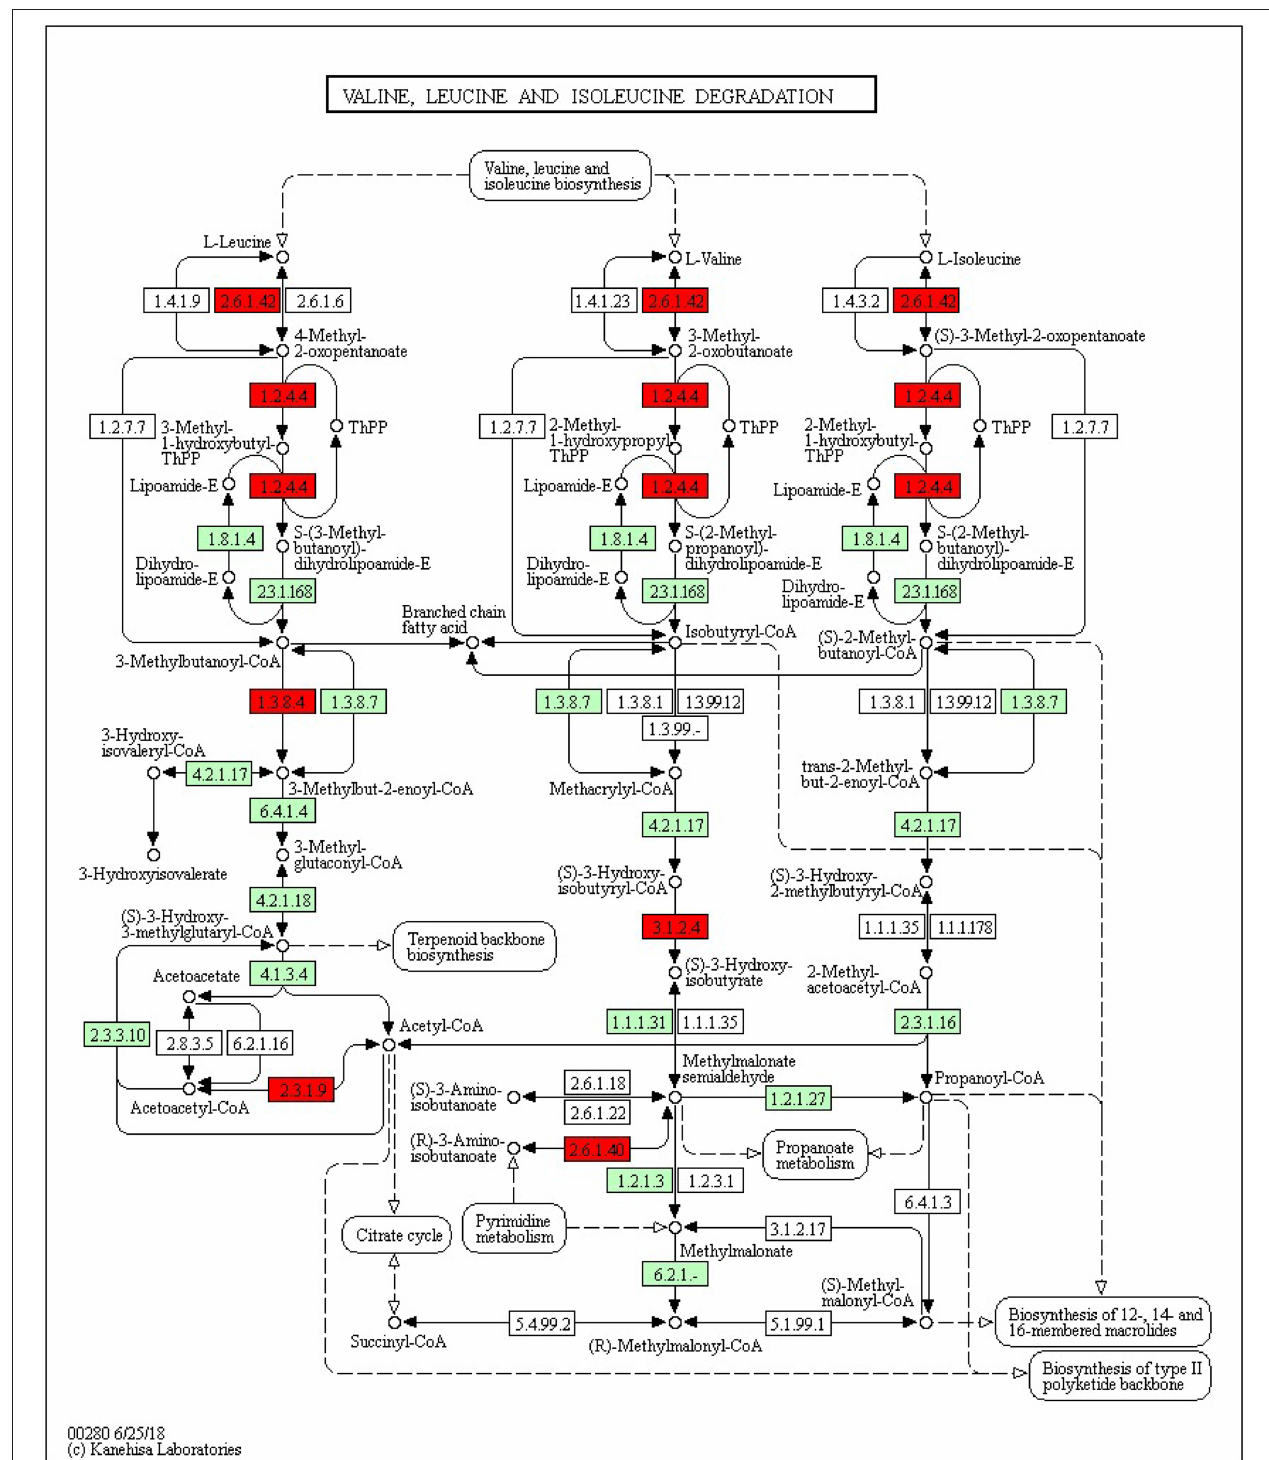
FIGURE 5 | Valine, leucine and isoleucine degradation pathway. (2.6.1.42) Branched-chain-amino-acid aminotransferase 5, chloroplastic isoform X1. (1.2.4.4) 2-oxoisovalerate dehydrogenase subunit beta 1, mitochondrial. (1.3.8.4) Isovaleryl-CoA dehydrogenase mitochondrial. (2.3.1.9) Acetyl-CoA acetyltransferase, cytosolic 1. (2.6.1.40) Alanine–glyoxylate aminotransferase 2 homolog 1, mitochondrial. Red color represents significant and characterized enzymes based on Oryza sativa annotation. Green color represents significant and non-characterized enzymes. White color represents characterized enzymes based on Arabidopsis thaliana